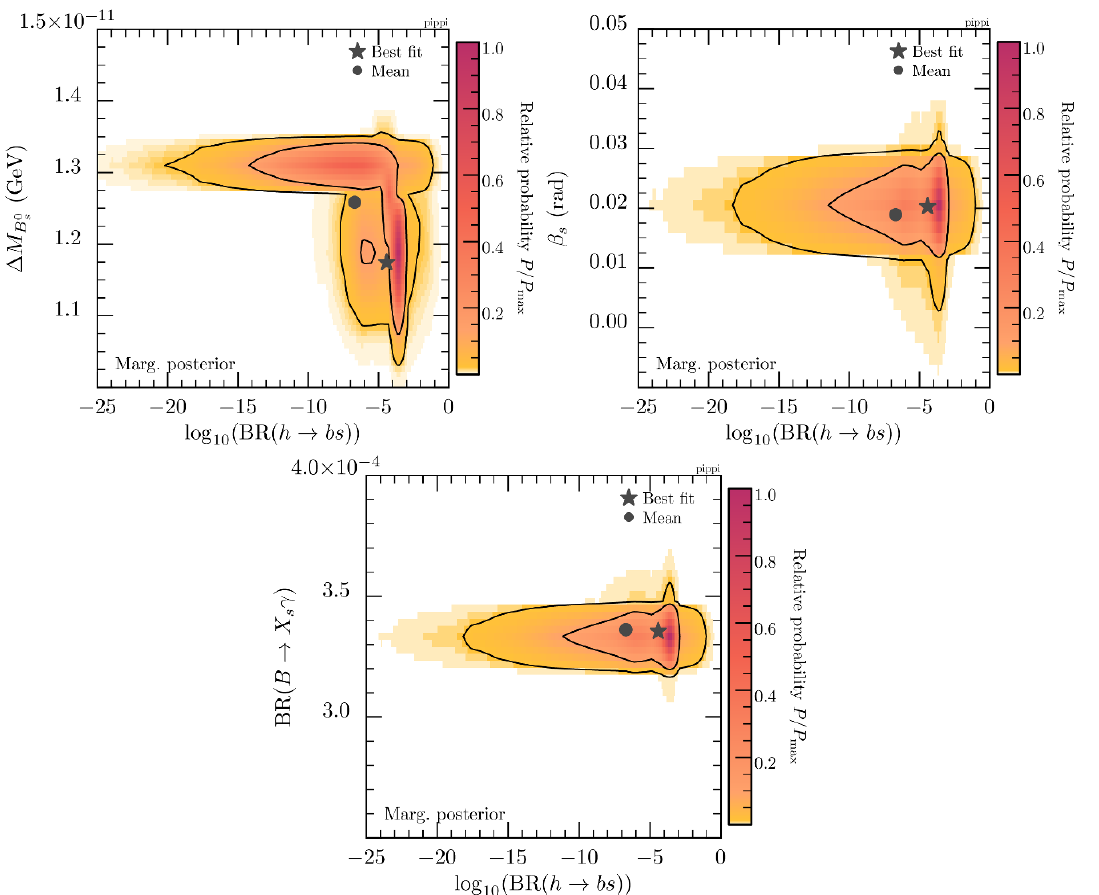
Figure 11 . Di(cid:11)erent observables and parameter versus log meson mixing mass splitting [CP phase]. Bottom : Radiative B decay BR( B ! X s (cid:13) ).